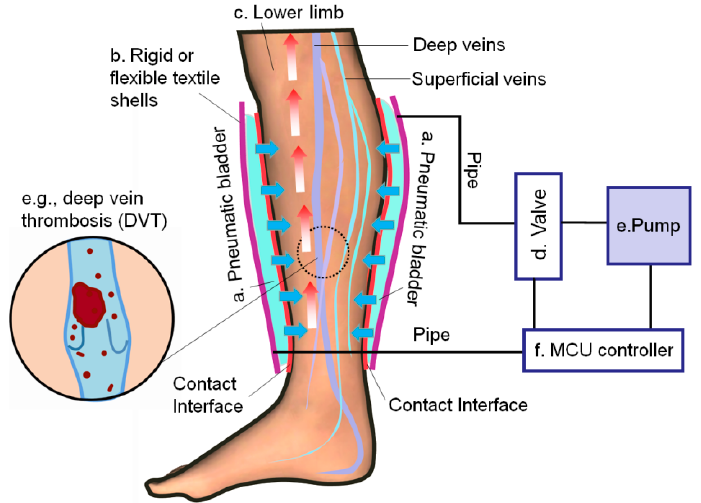
Figure 1. A schematic diagram of the typical intermittent pneumatic compression (IPC) device in compression therapy of lower extremity.